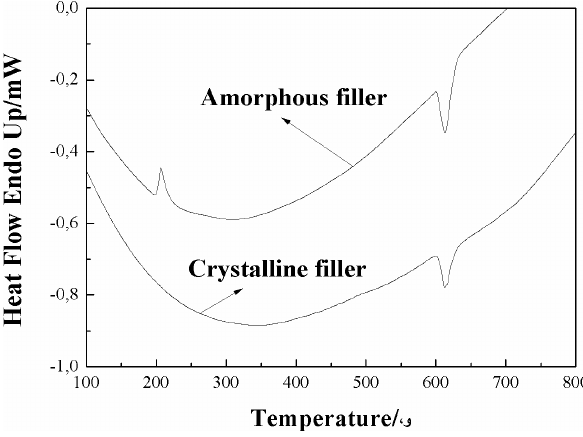
Figure 4: DSC curves of the amorphous and crystalline filler metals